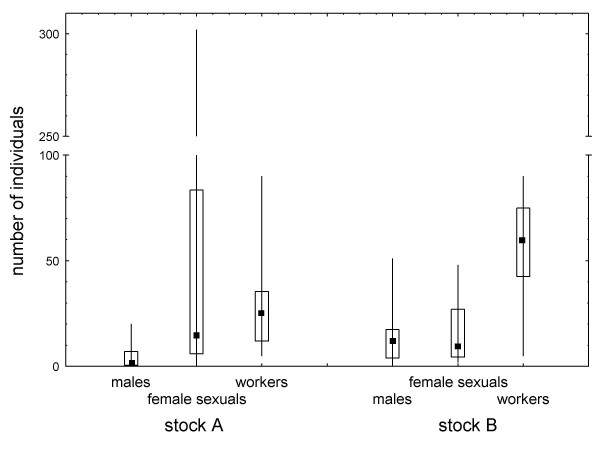
Number of males, female sexuals, and workers (median, quartiles, range) queens of the ant Cardiocondyla kagutsuchi from two different genetic lineages (stock A: 22 queens, stock B: 16 queens) produced during their lives. Stock A queens produced a significantly more female-biased sex ratio and female larvae with a significantly higher queen bias (female sexuals/all females) than stock B queens.